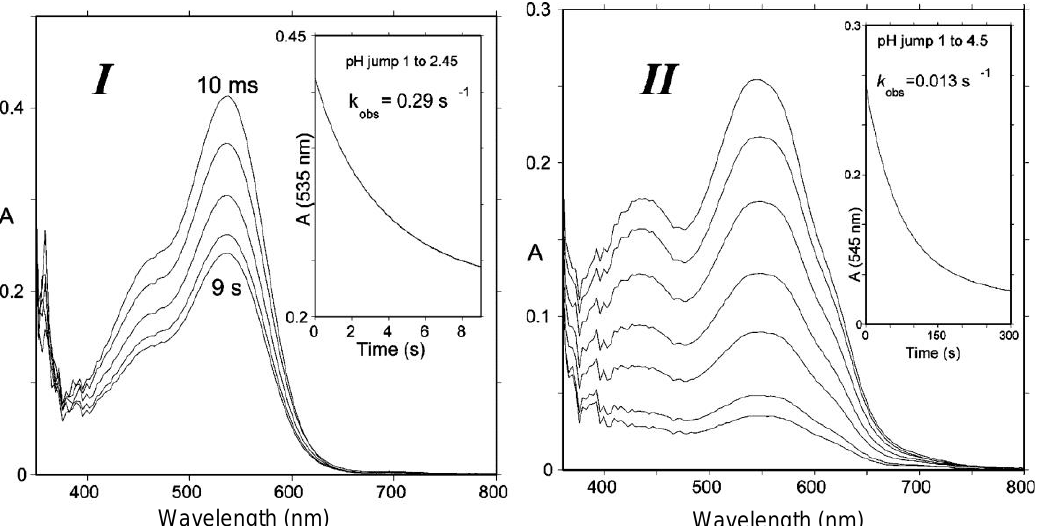
Figure 5. ( I ) Spectral changes of Cat-Mv3Glc between 10 ms and 9 s following a pH jump from pH = 1 to pH = 2.45; half-life of flavylium = 2.4 s. ( II ) pH jump from pH = 1 to pH = 4.5; half-life of quinonoid bases = 53.3 s. At pH = 6, the half-life of quinonoid bases ≈ 30 min. From reference [4] with permission of the American Chemical Society